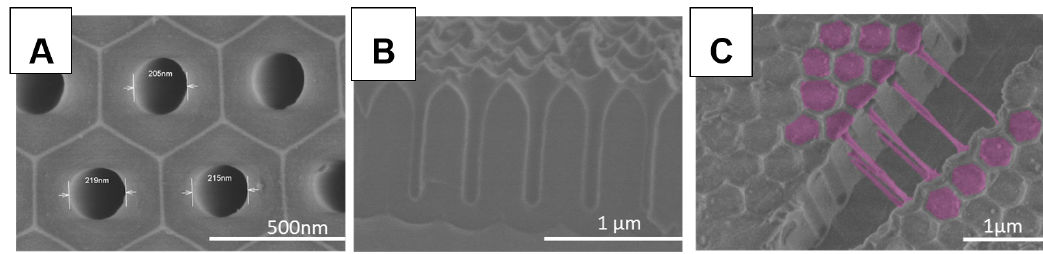
Figure 1. SEM images from ( A ) Top view and ( B ) Lateral view of synthesized anodic aluminium oxide (AAO) template. ( C ) Top view of a cracked template after in-situ polymerization of 2-hydroxyethyl acrylate (HEA) and butyl methacrylate (BMA).